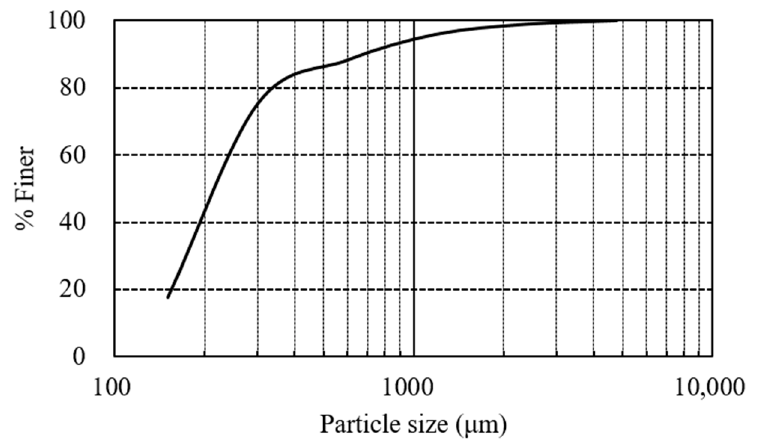
Figure 4. Particle size distribution curve.